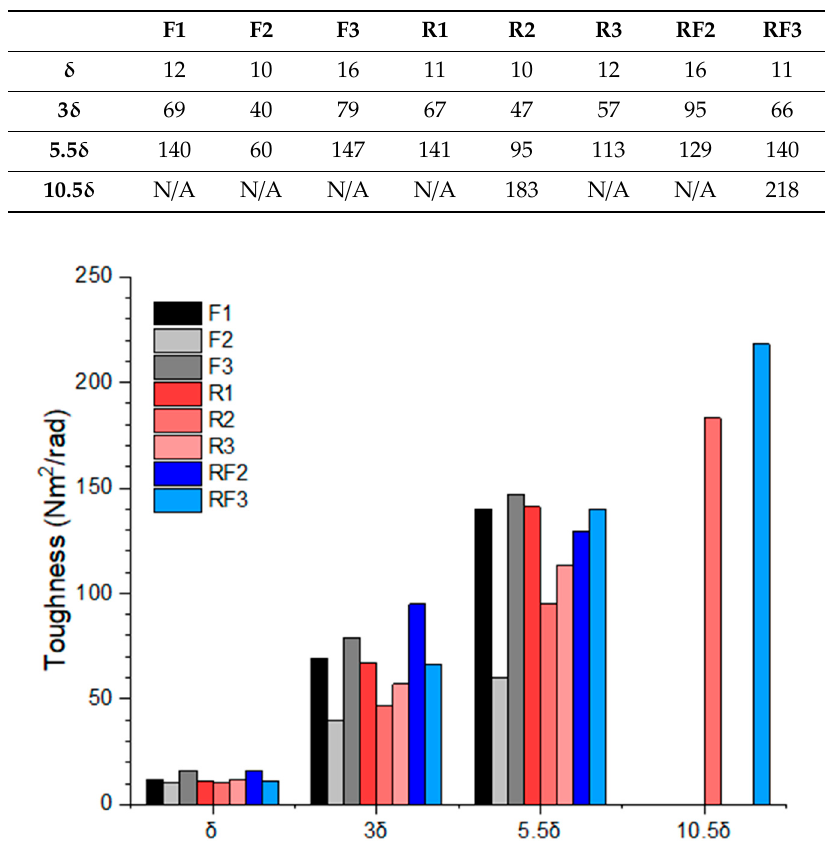
Table 6. The area under the curve of torque versus angle of twist (Nm 2 / rad) at δ , 3 δ , 5.5 δ and 10.5 δ .